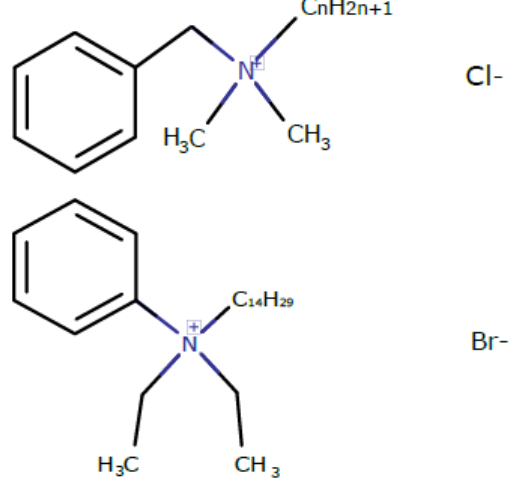
Figure 1. Chemical structures of benzalkonium chloride (BAC; top) and Kor105 (bottom).